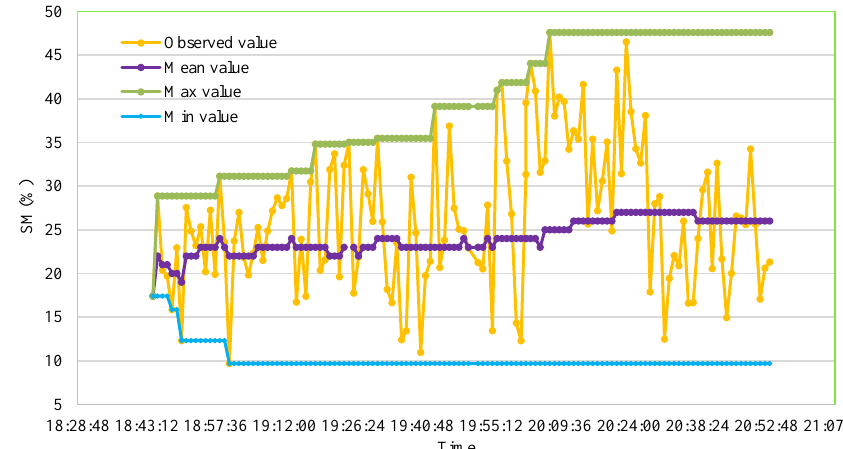
Figure 9. The SM value, max SM value, min SM value, and mean SM value near real-time curves.